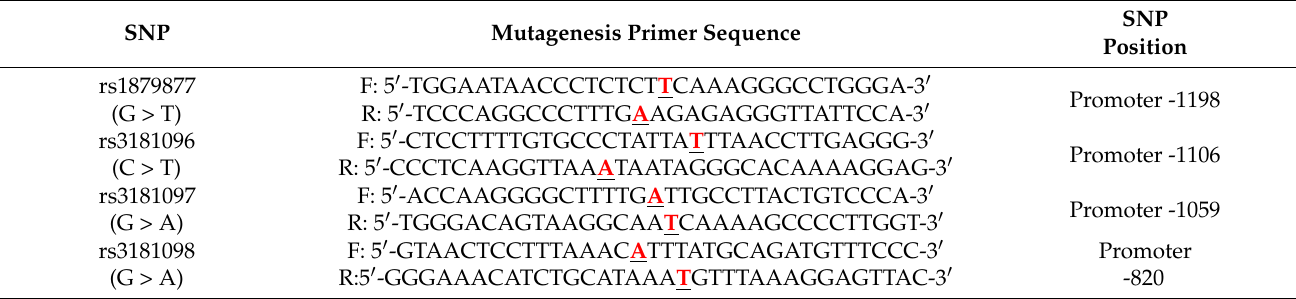
Mutagenesis Primer